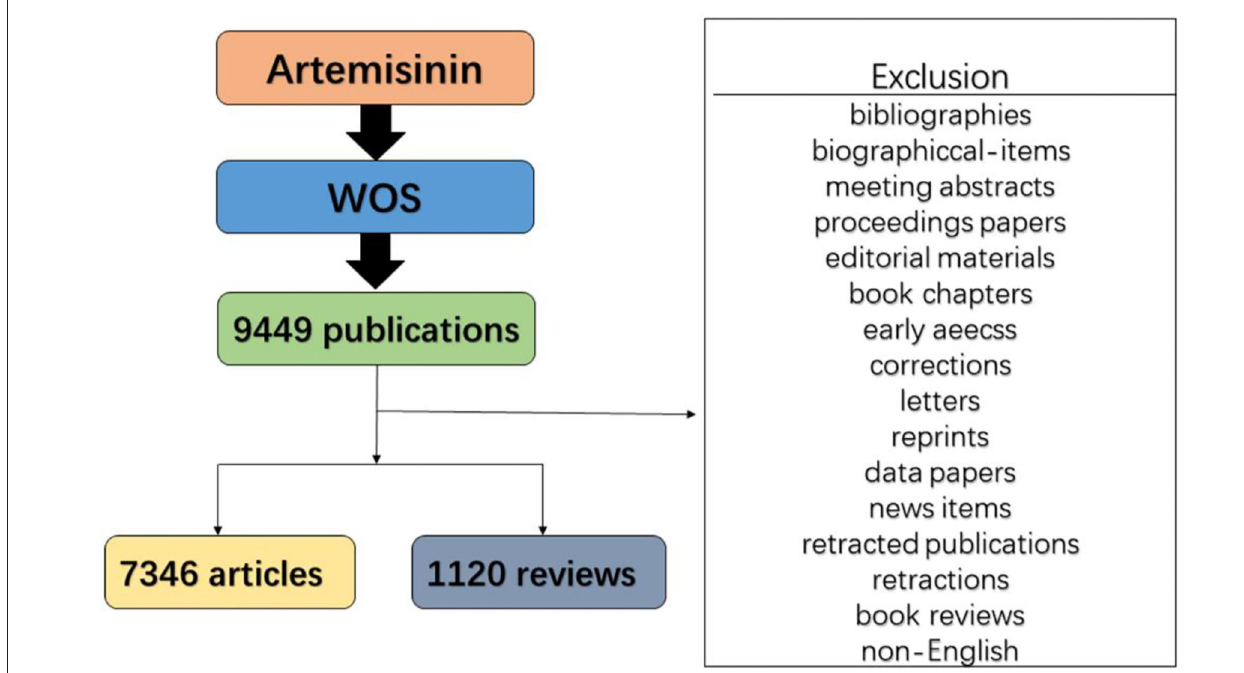
FIGURE 1 | Flowchart of the screening process.